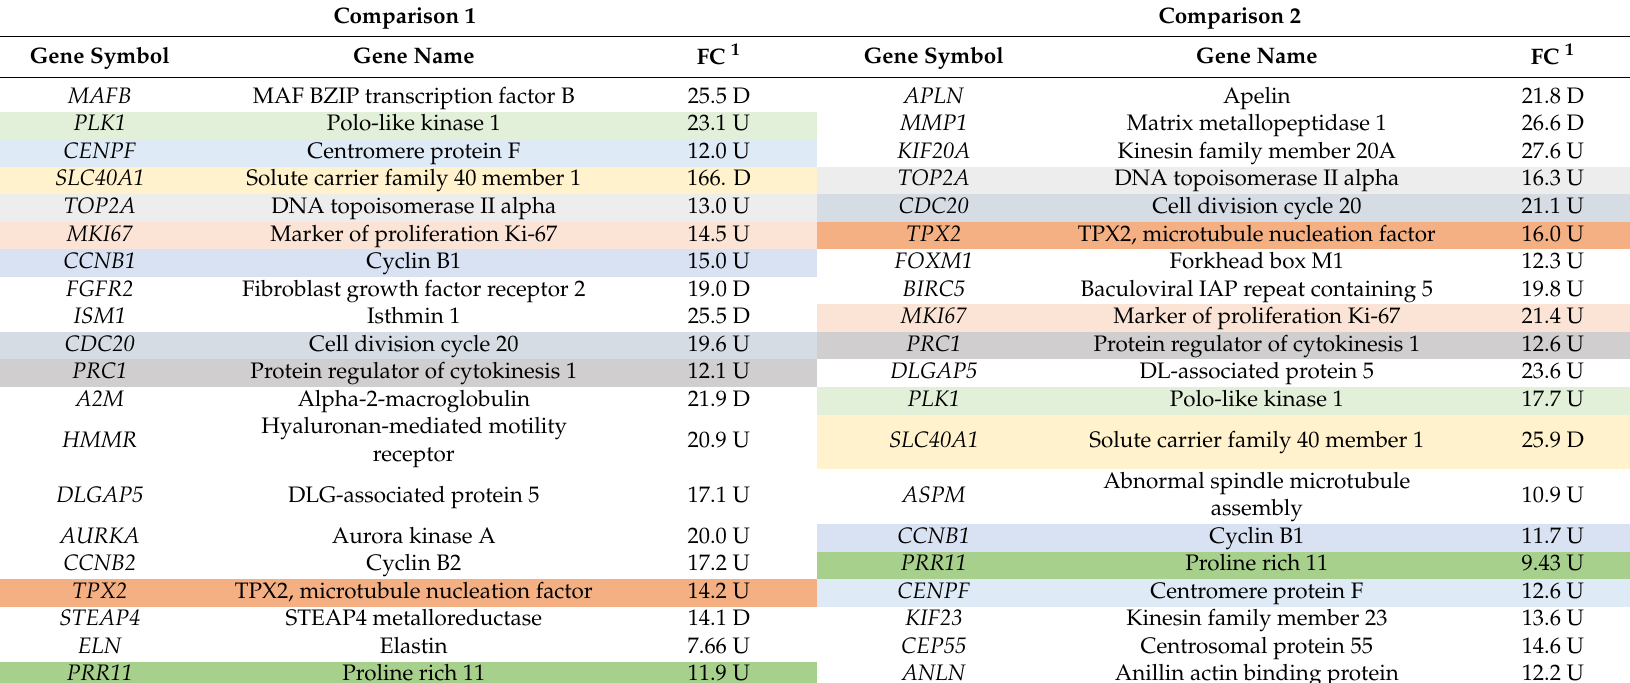
Table 2. Top 20 differentially expressed genes in comparisons 1 and